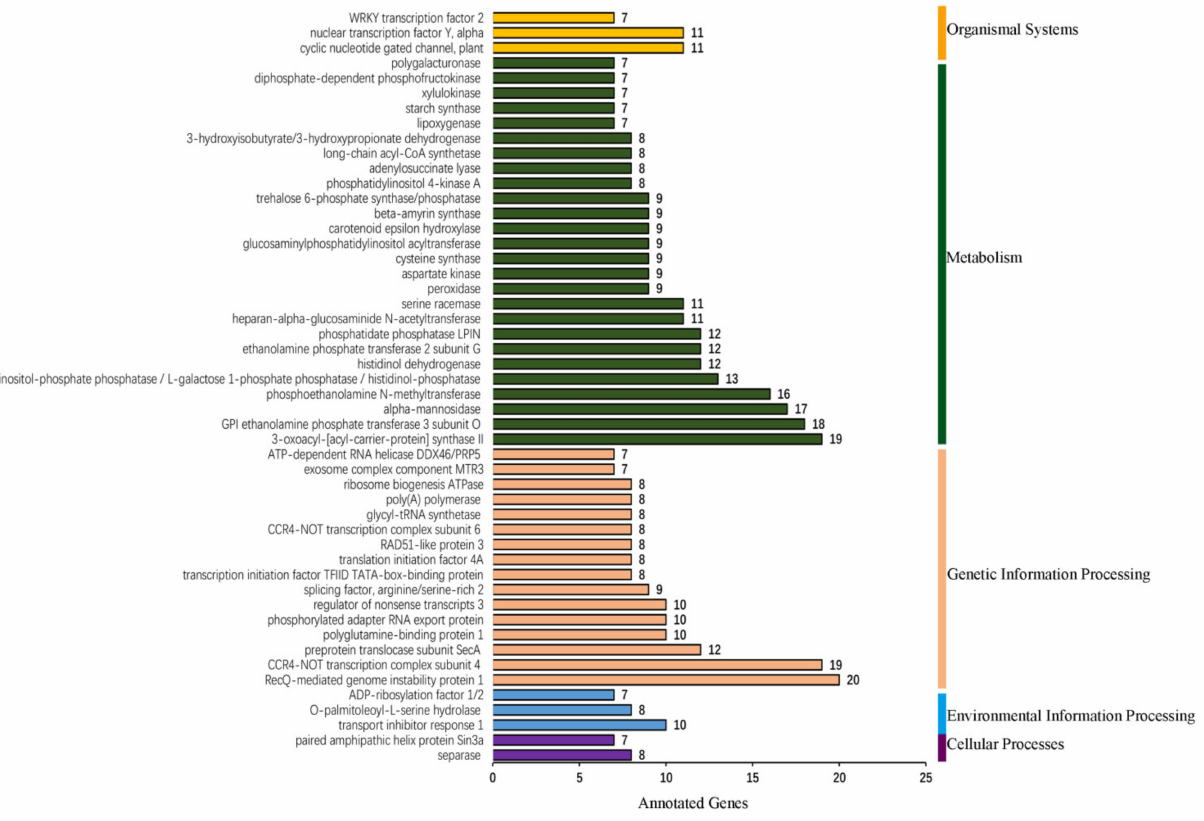
Figure 3. KEGG enrichment of miRNA targets. Table 1. MiRNAs target structural genes potentially involved in cannabinoids, fatty acid and cellulose biosynthesis. miRNA